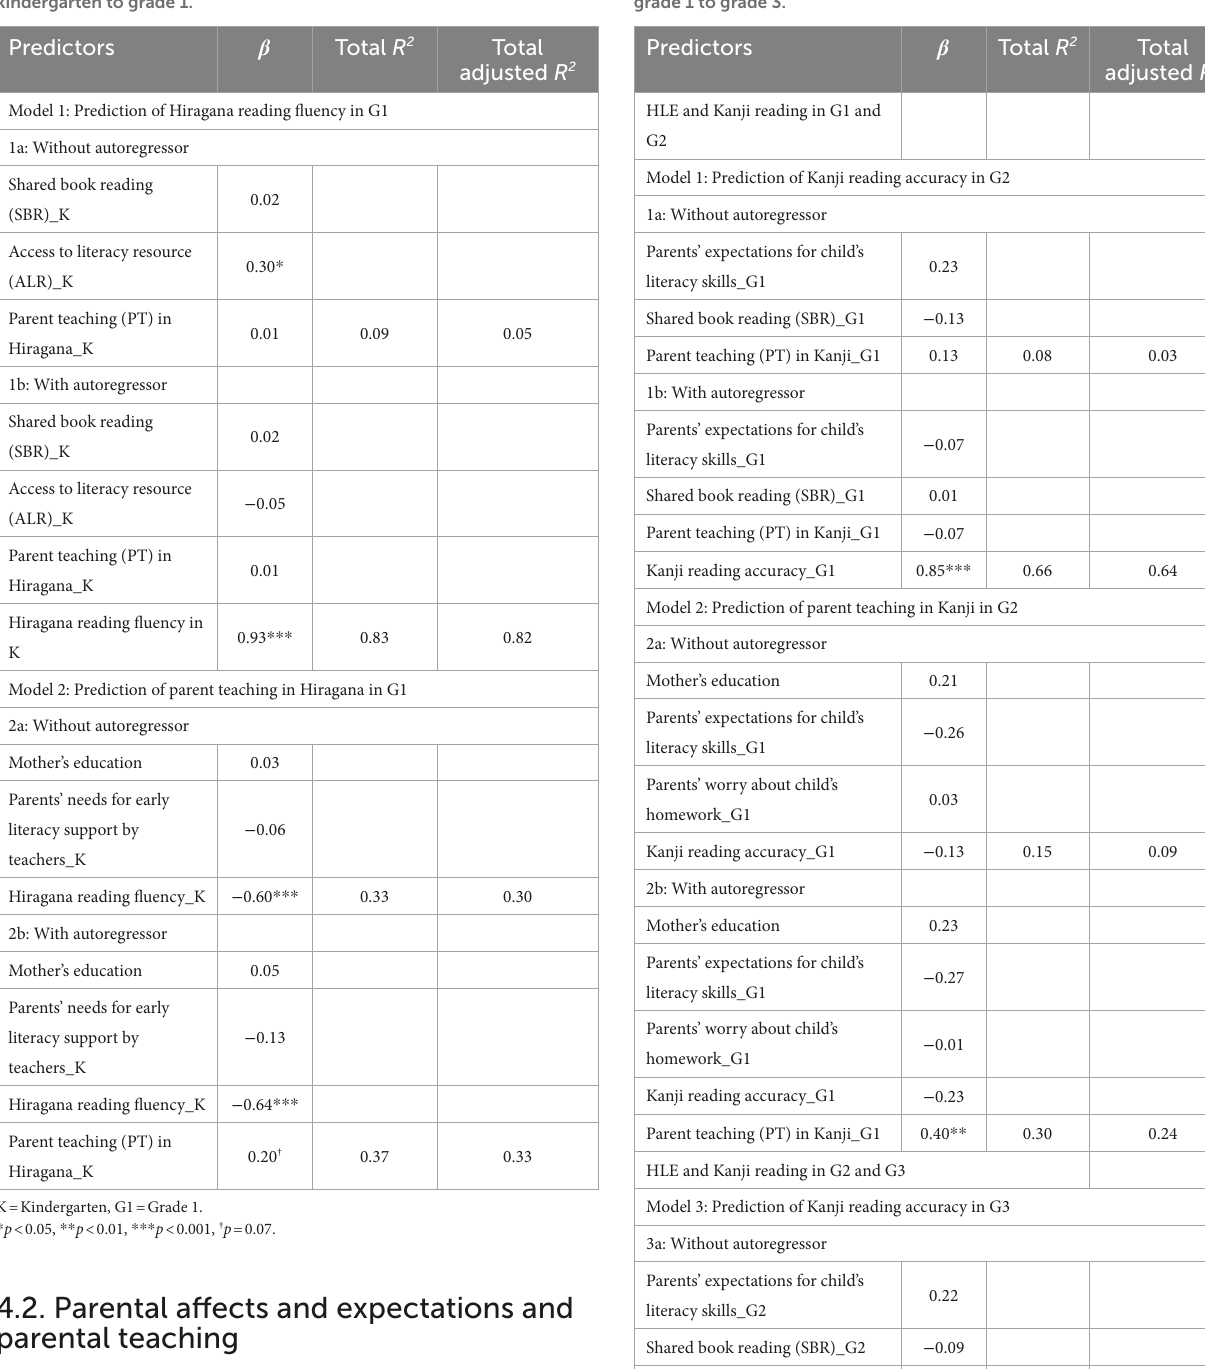
TABLE 4 Multiple regression analyzes for HLE and Hiragana reading from kindergarten to grade 1.